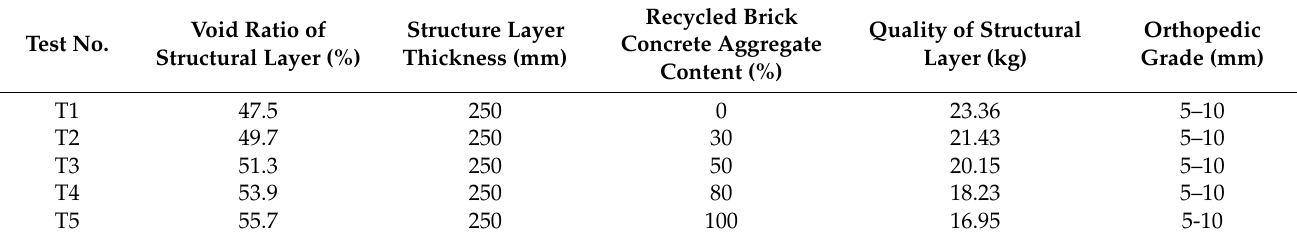
Table 3. Filler of test structural layer.